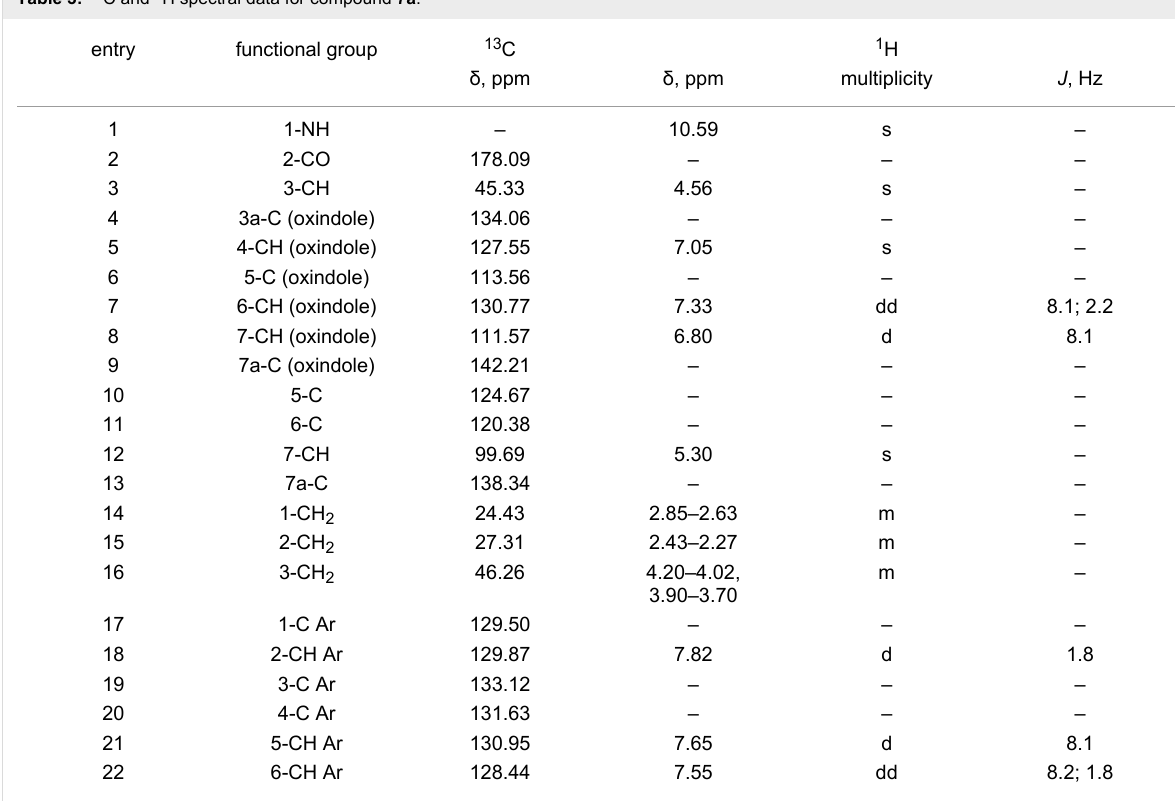
Table 3: 13 C and 1 H spectral data for compound 7a